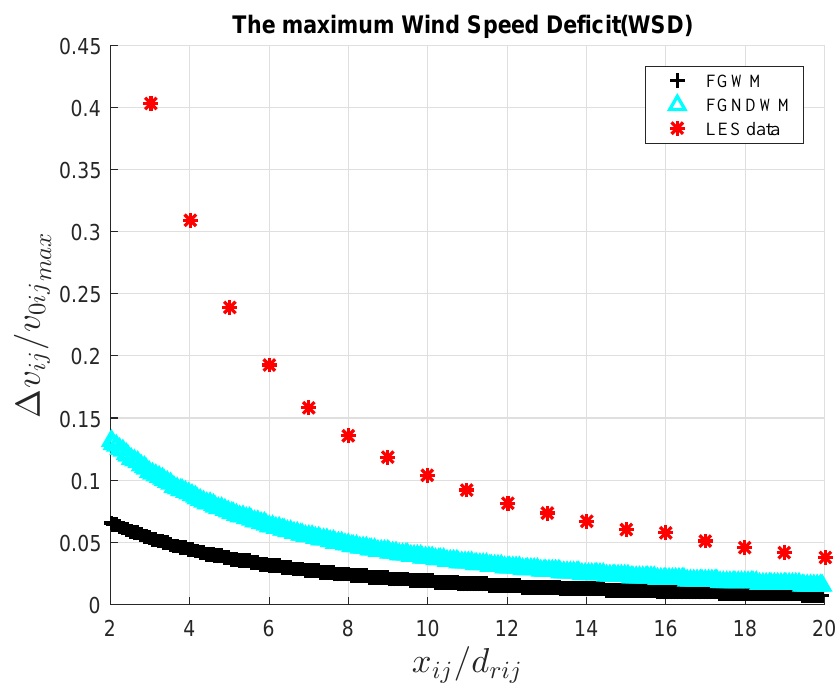
Figure 7. The portrait of the maximum Wind Speed Deficit (WSD) in Case c (fitted by LES data, i = 1,2, · · · , N ; j = 1,2, · · · , N